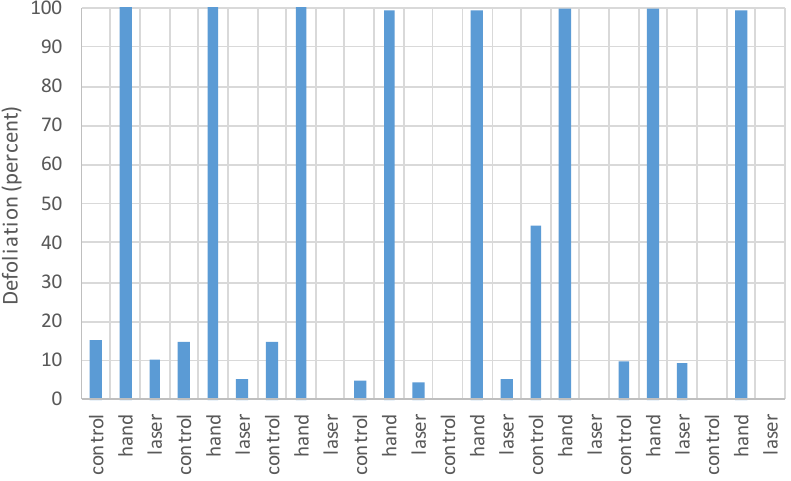
Figure 9. Defoliation efficacy for greenhouse-grown plants utilizing small 4 L pots for replicated comparison of (control, hand-girdled, laser-girdled).